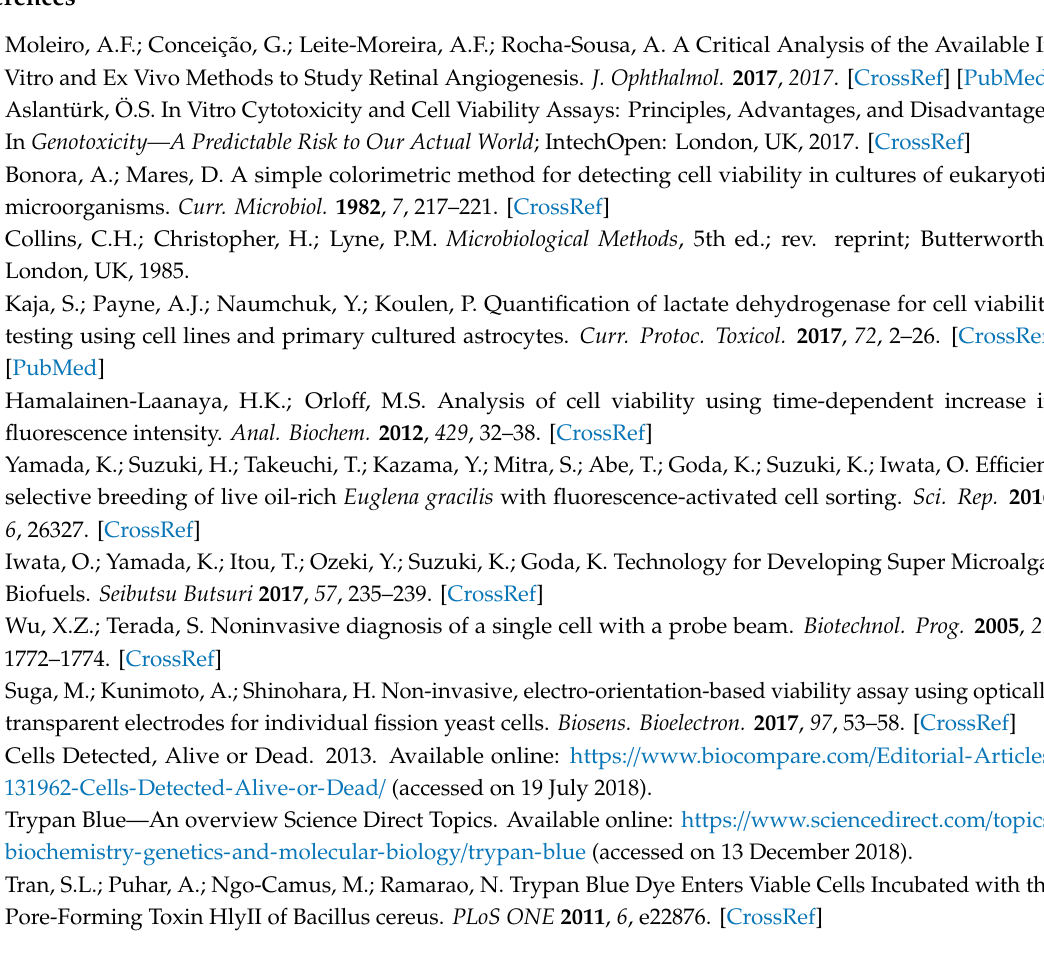
Figure S1: Confirmation of staining of dead cells, Figure S2: Confirmation of staining of dead